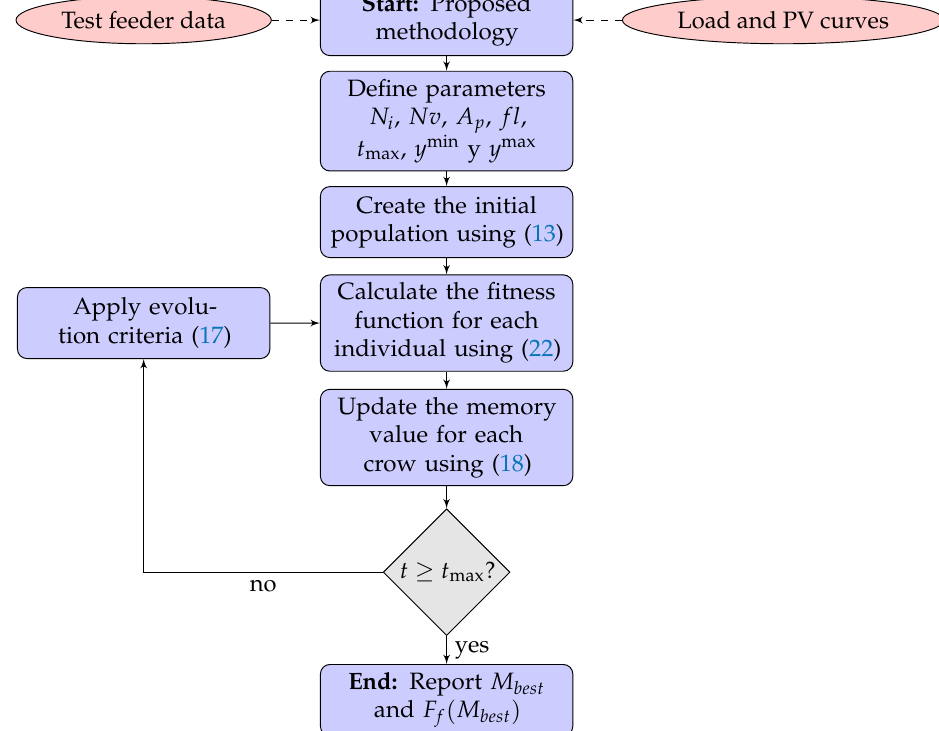
Figure 1. General application of the master–slave approach to address the problem of optimal integration of PV generating units in DC